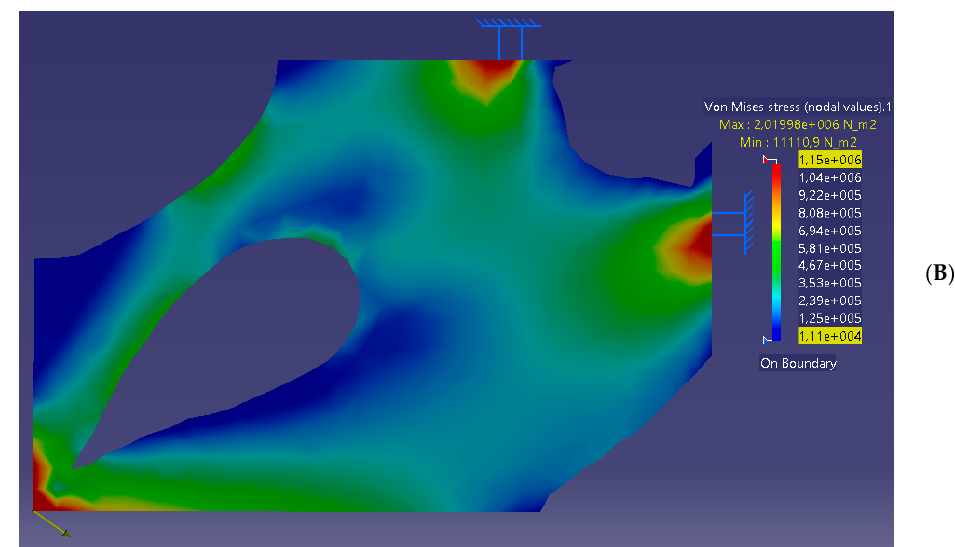
Figure 16. Comparison of ( A ) AM shaped part and ( B ) TO using SIMP part.